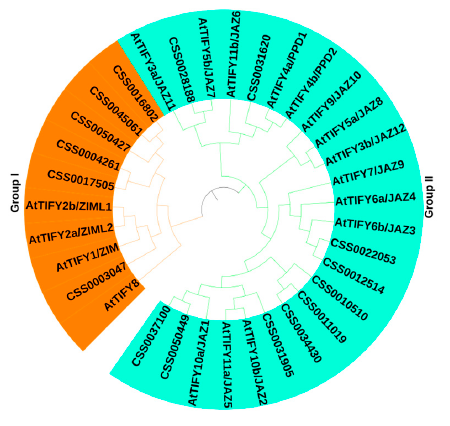
Figure 1. Phylogenetic tree of TIFY proteins from tea plant and Arabidopsis. The predicted full-length amino acid sequences of 16 CsTIFY and 18 AtTIFY were used to construct a phylogenetic tree using MEGA5.1 by the neighbor-joining method. The branch of Group I is marked in orange and that of Group II is marked in green.